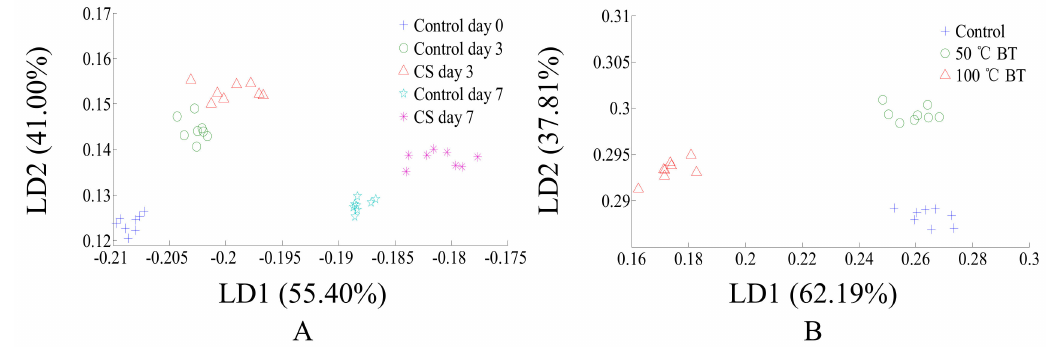
Figure 6. LDA results of different postharvest handling treatments. ( A ) CS, ( B )